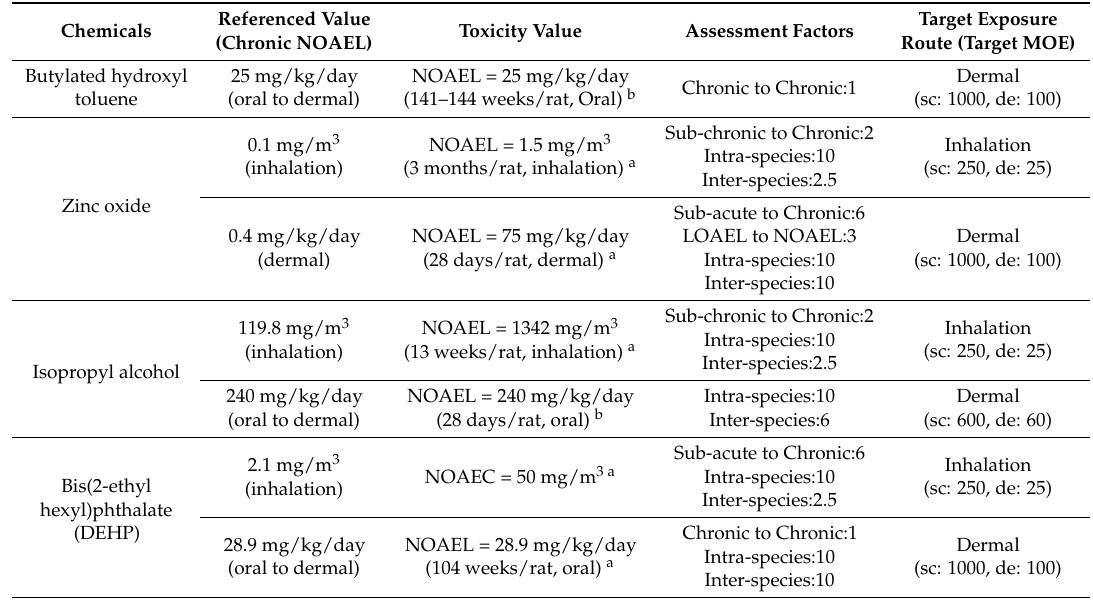
Table 3. Summary of toxicological end-point and default chronic NOAEL for the ingredients